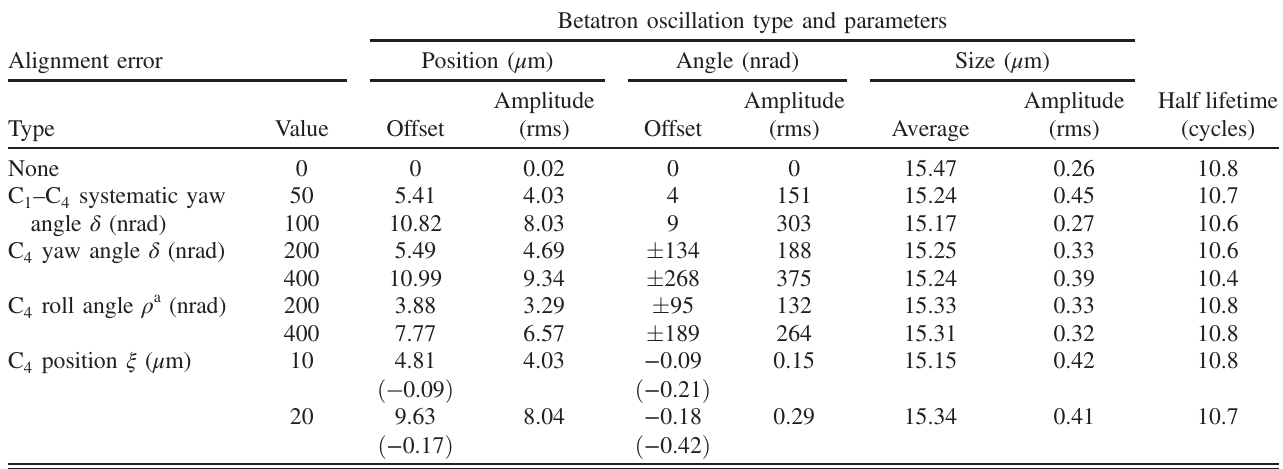
TABLE IV. X-ray beam characteristics at the source position calculated for various crystal misalignment types from the data in Figs. 13 – 16. A second sign for offset values is provided if the sign differs between the source and the midpoint. Offset values for both locations are given for the crystal position error case.